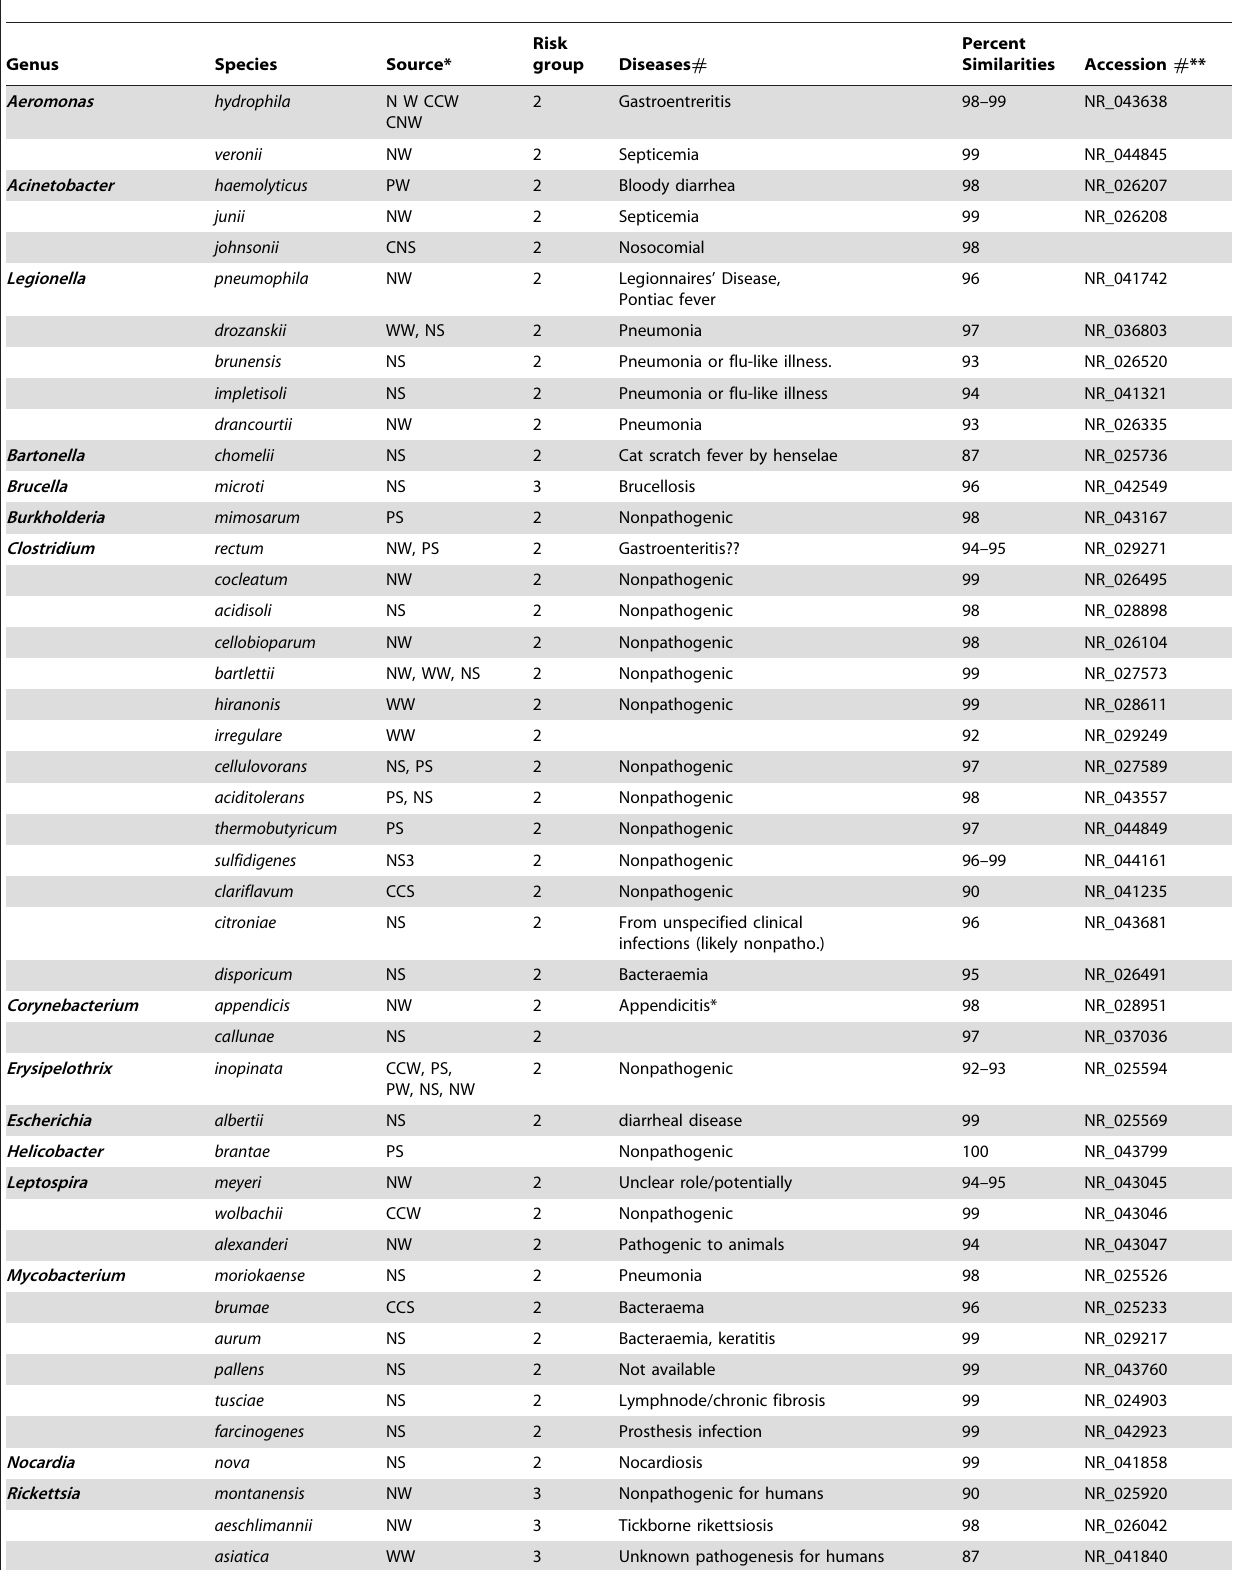
Table 3. List of potential human pathogenic bacterial sequences identified from different sources within the Santa Ana watershed using 454 pyrosequencing obtained from RDP Classifier